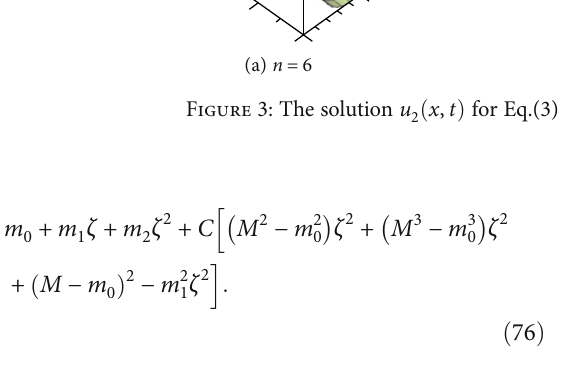
Figure 3: The solution u